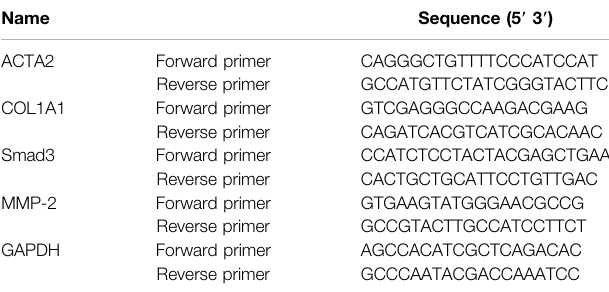
TABLE 1 | Human primers for quantitative real-time PCR